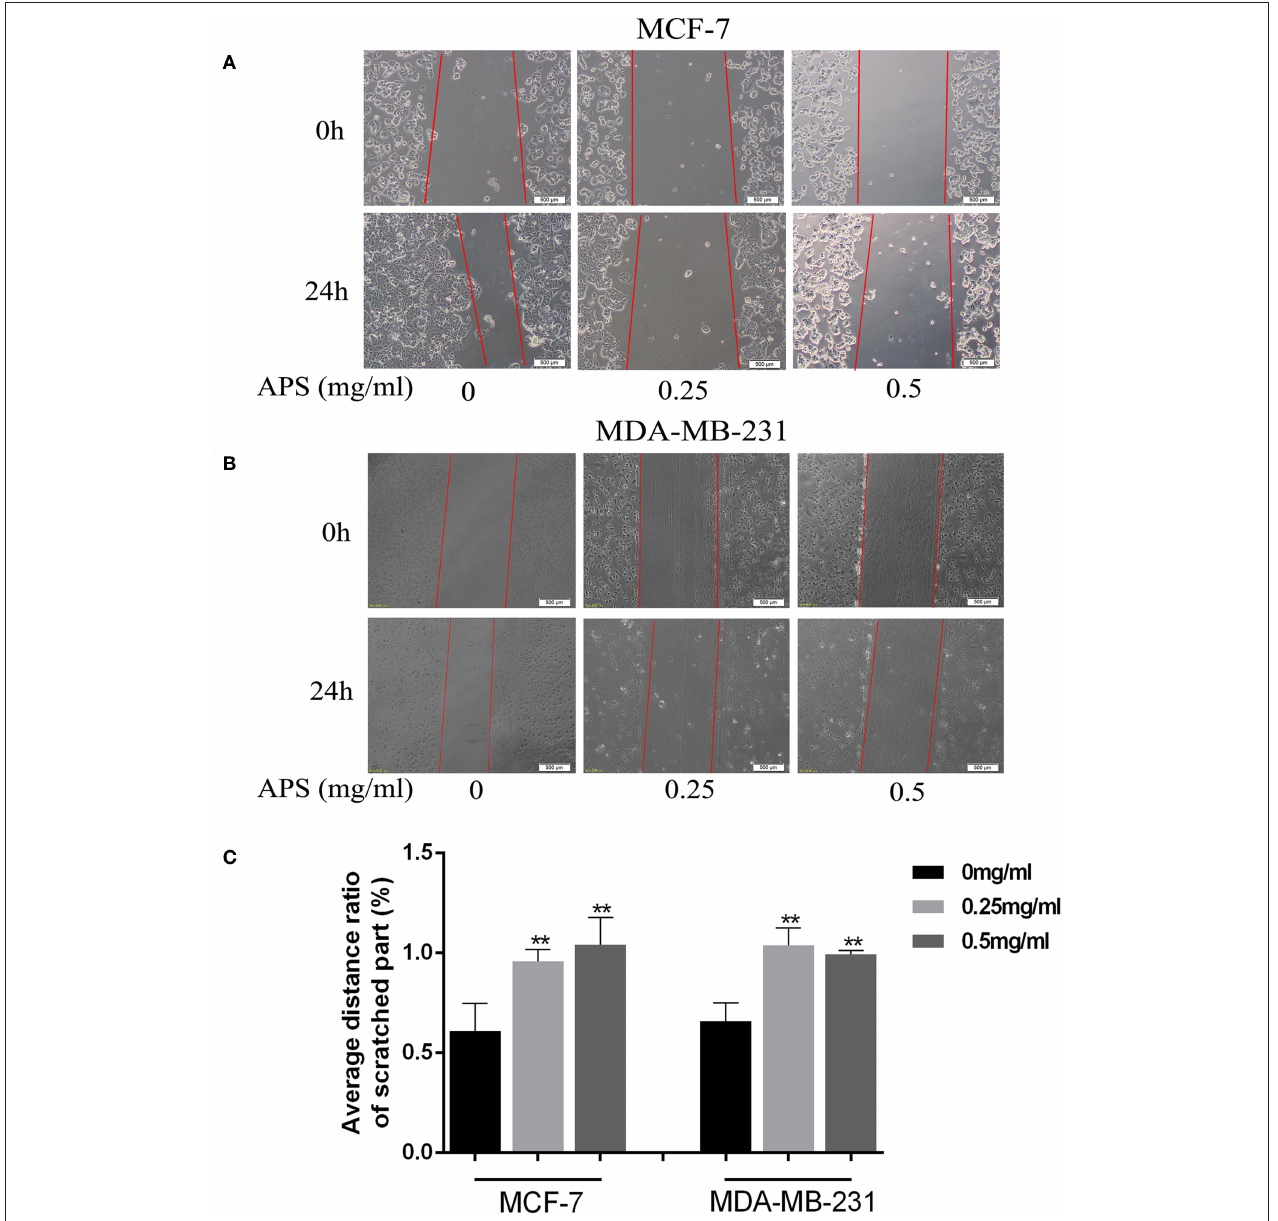
FIGURE 10 | APS significantly inhibited cell migration of BC cells. Effects of APS (0, 0.25, 0.5 mg/ml) on migration of BC cells, MCF-7, and MDA-MB-231 cells were used to assess cell migration, the distance of cell movement was measured and photographed under an inverted microscope (100 × ). (A,B) Representative images of cells that migrated during wound-healing. (C) Graph of average distance ratio of scratches. * p < 0.05, ** p < 0.01 vs. control (0